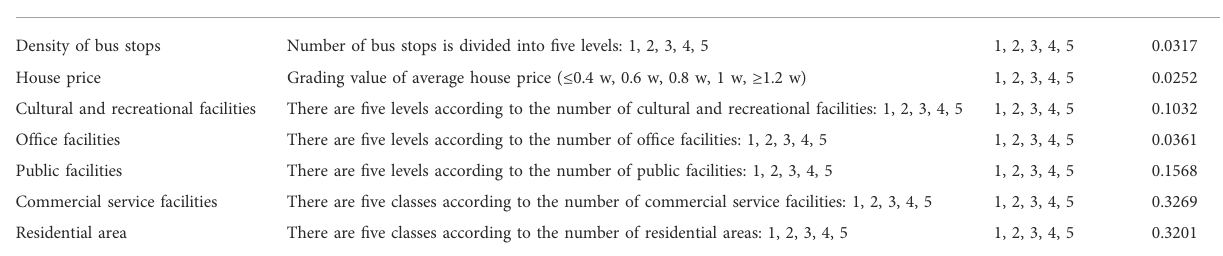
TABLE 4 Index score of GIS